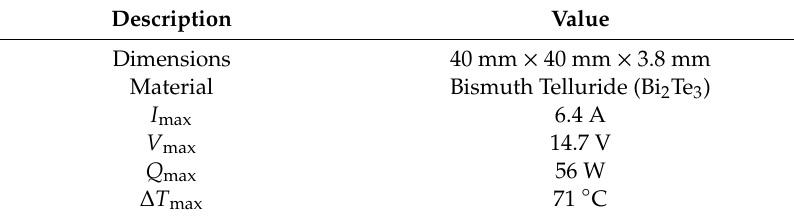
Table 1. Technical specifications of the TEM used in this study.